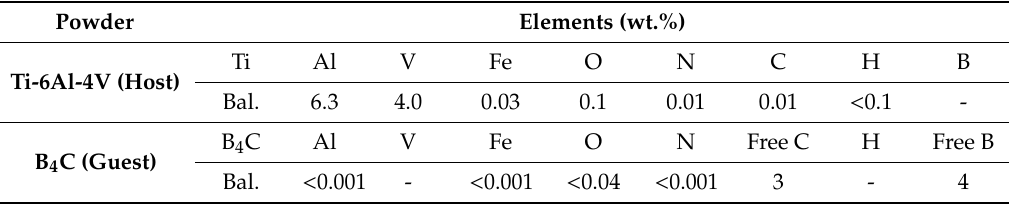
Table 1. Nominal chemical composition of the starting Ti-6Al-4V and B 4 C powders.